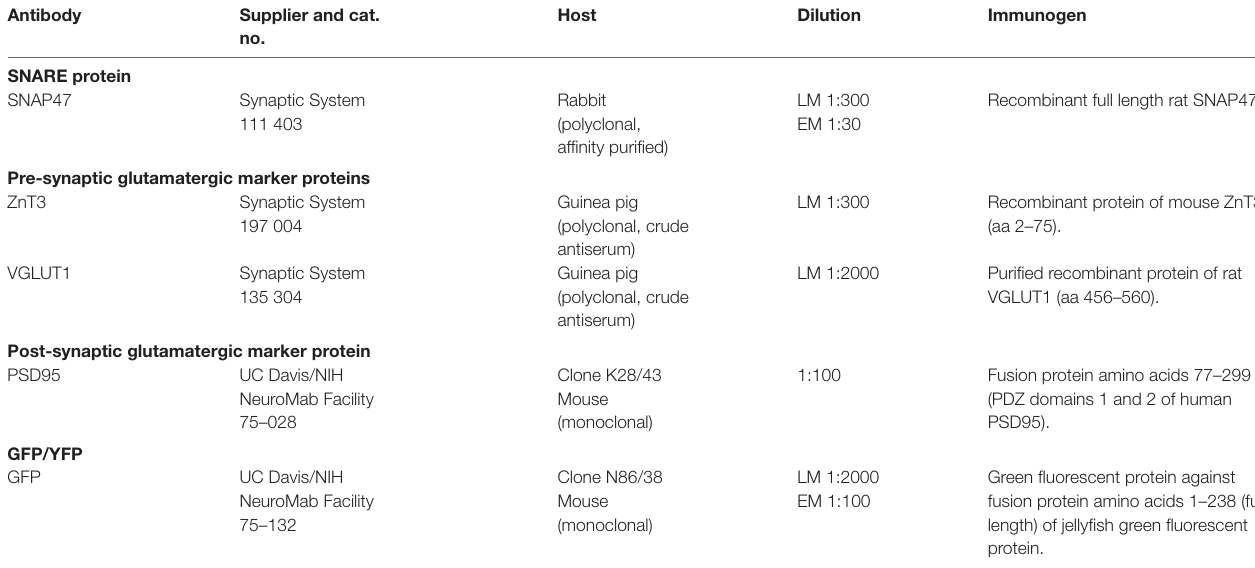
TABLE 1 | List of primary antibodies for immunocytochemistry. Antibody Supplier and